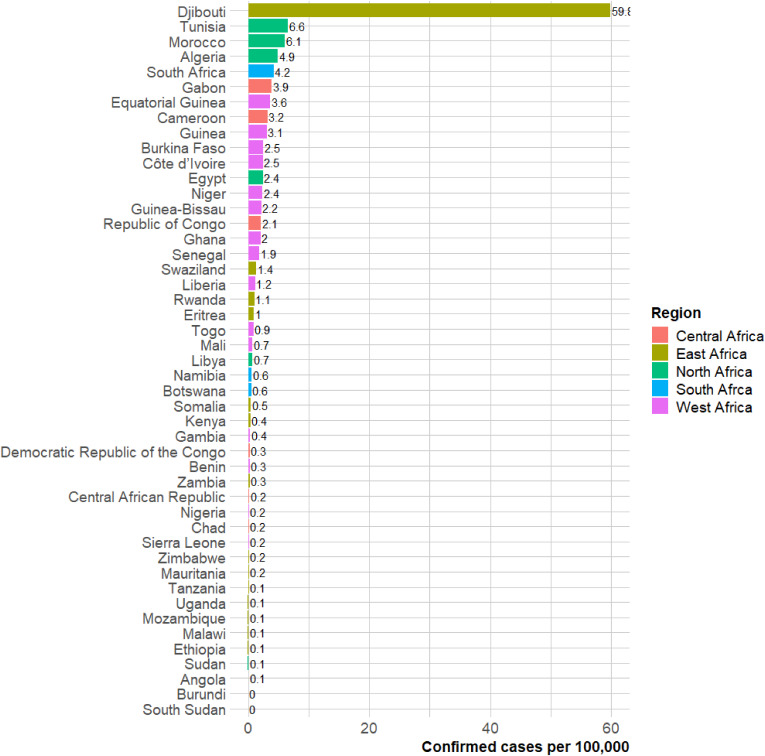
Burden (cases per 100,000 population) of COVID-19 across Africa as at 16th April 2020.